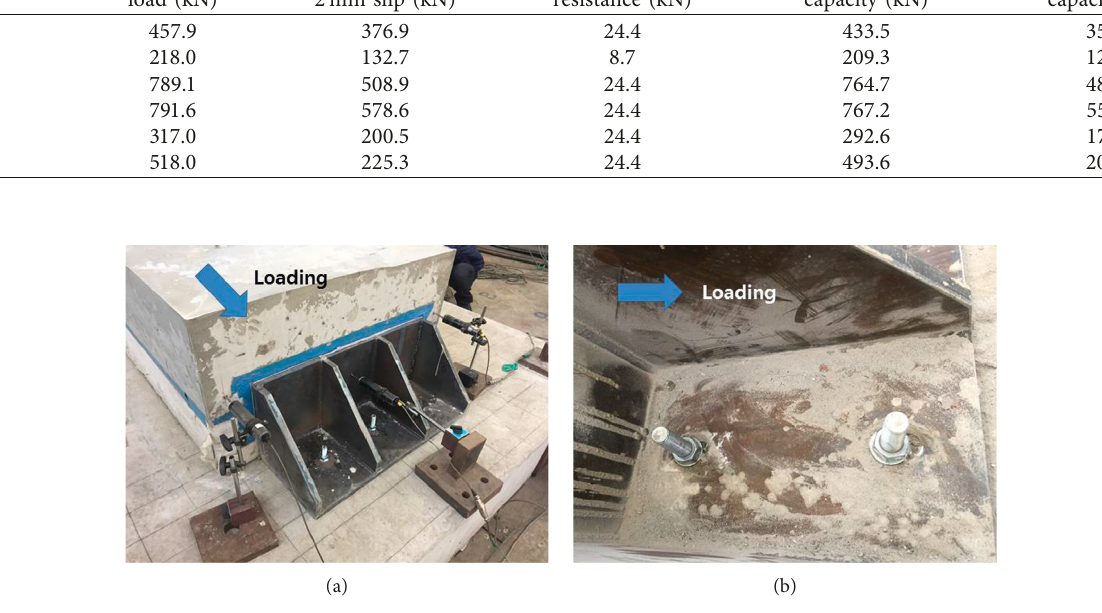
Figure 13: Damage on the anchor bolts under the transverse load: (a) Specimen AT and (b) Specimen BT.